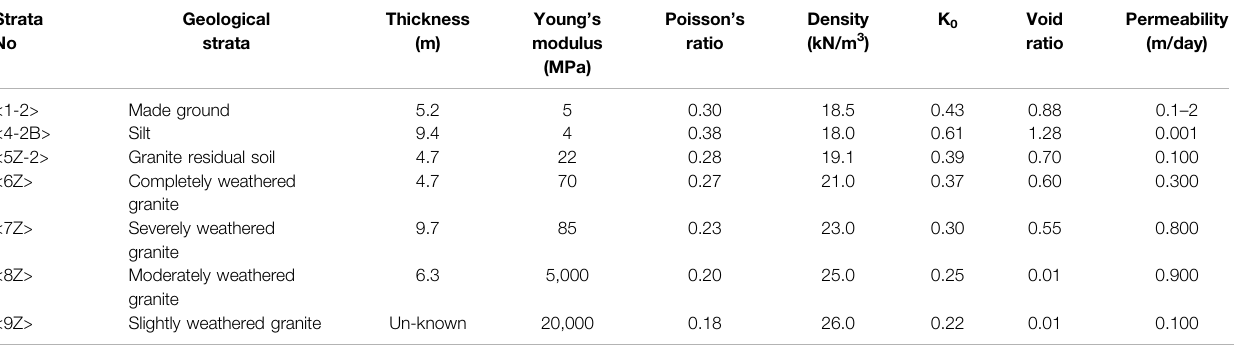
TABLE 1 | Geological strati fi cation and geotechnical parameters for the ground around the